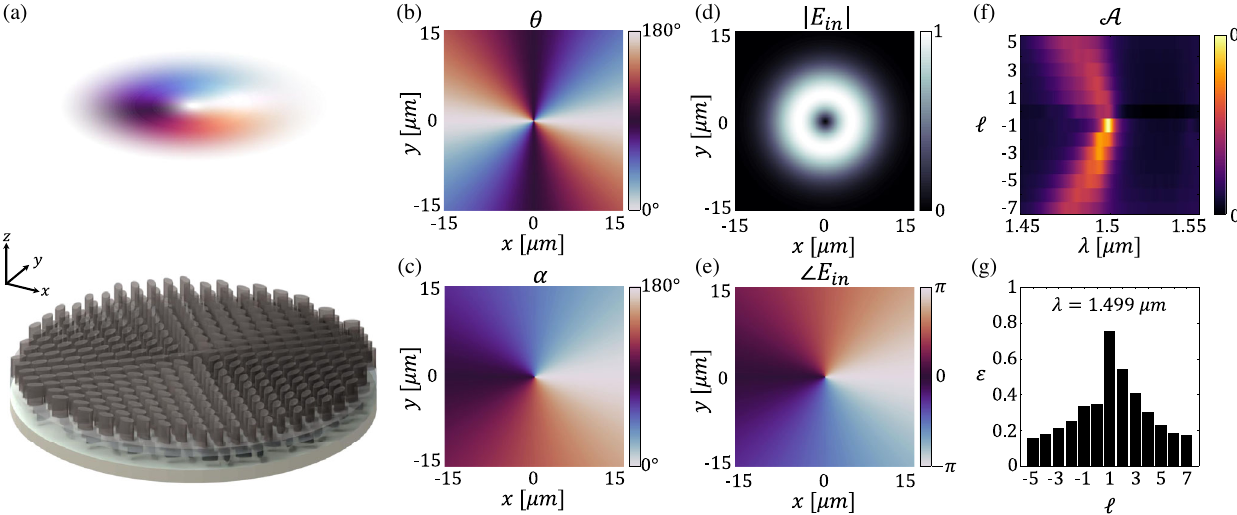
FIG. 9. Thermal metasurface generating quasimonochromatic SAM or OAM light. (a) Schematic of a thermal metasurface with an azimuthally varying directivity. (b),(c) Angular parameters defining a 30 × 30 μ m thermal metasurface generating RCP light with an OAM of l ¼ 1 at λ ¼ 1 . 5 μ m. (d),(e) Example electric field profile of LCP light launched in full-wave simulations to study the absorption of normally incident OAM light. (f) Absorption spectra for various OAM beams such as that depicted in (d) and (e). (g) Emissivity into the OAM channels at the peak wavelength, λ ¼ 1 . 499 μ m, showing preferential emission to the designed OAM order and emission with overall net OAM.